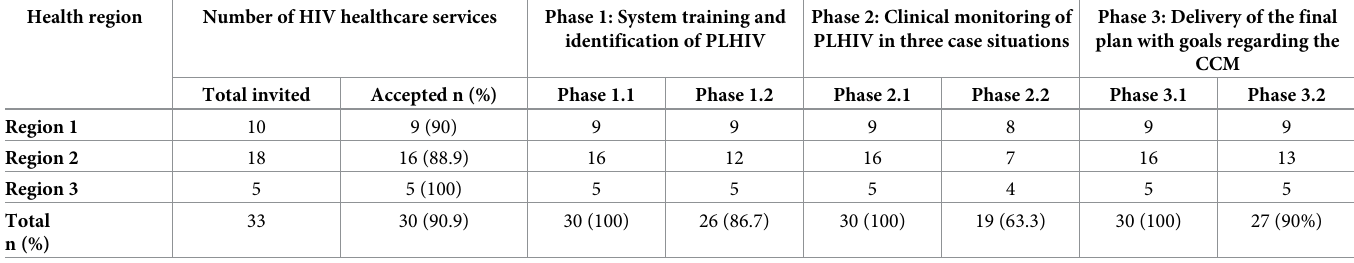
Table 1. Number of HIV healthcare services that participated in the intervention according to intervention phase and health region.